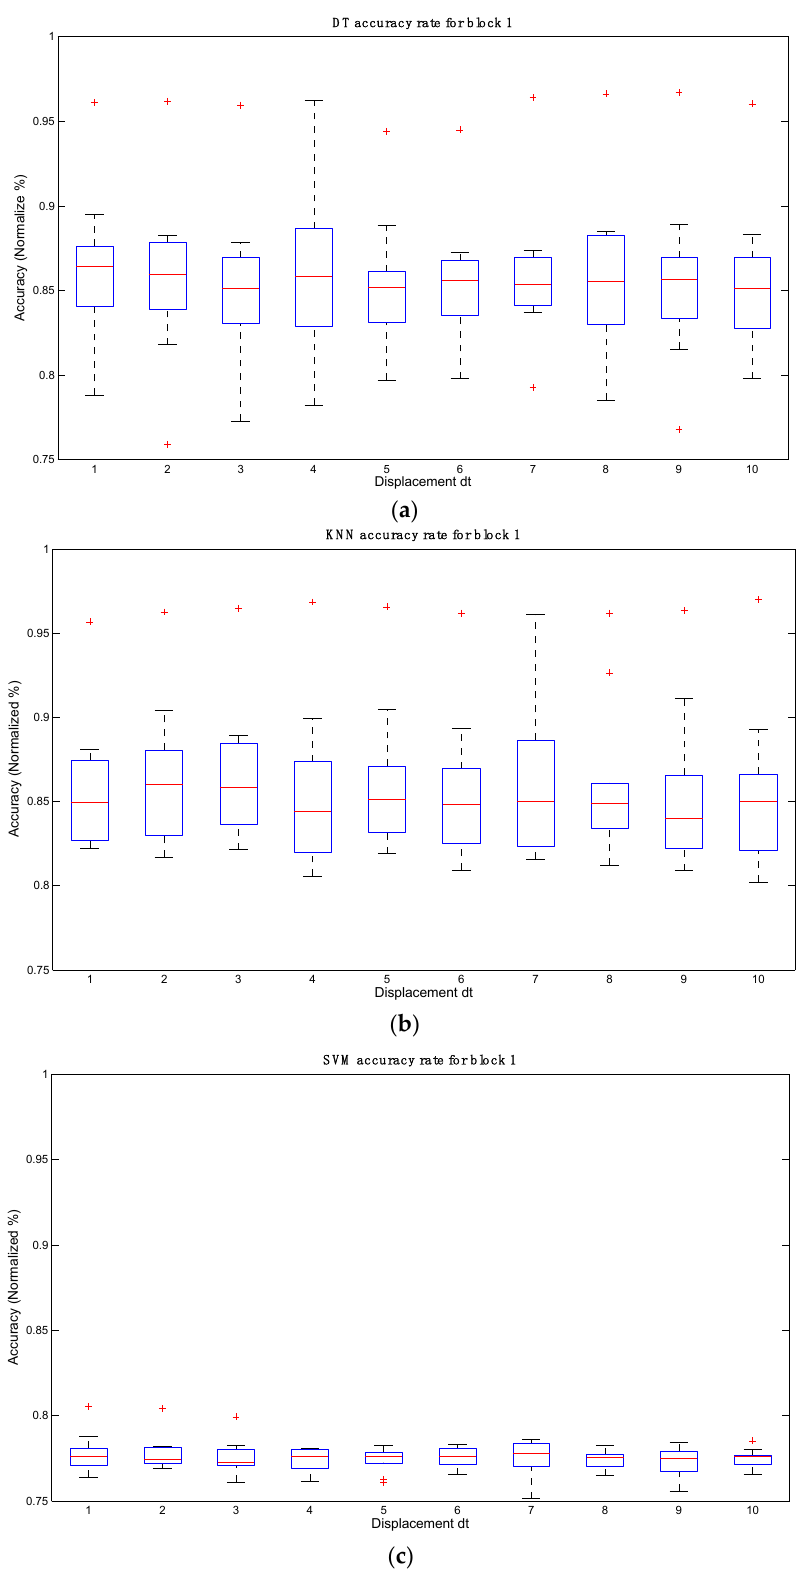
Figure 8. Graphical representation of accuracy rates for block 1 using: ( a ) DT; ( b ) KNN and ( c ) SVM for block 1 and dt = 4.